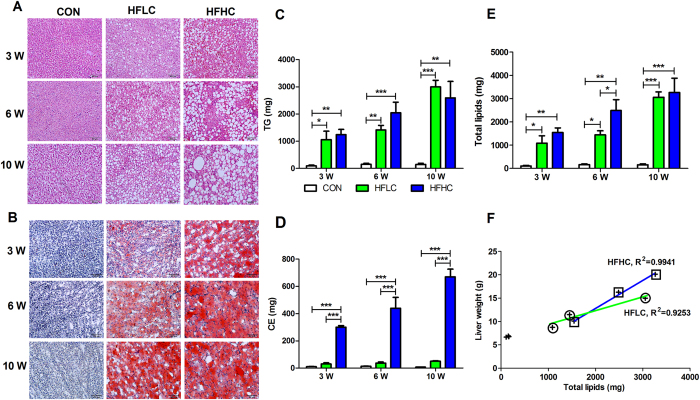
HFLC and HFHC caused lipid accumulation in liver.Liver histology showed that both HFLC and HFHC diets induced steatosis as indicated by hematoxylin-eosin (HE) staining (A), and Oil Red O staining (B). Scale bars: 100 μm. (C) Both HFLC and HFHC diets remarkably increased hepatic triglycerides (TG) content. (D) Only HFHC diet increased cholesterol esters (CE) in the liver. (E) Total lipids (TG + CE) in liver. (F) Linear relationship between liver weight and total lipids in HFHC (R2 = 0.9941) and HFLC (R2 = 0.9253). Data are presented as mean ± SEM of 3–4 animals. Significant difference between two groups, *P < 0.05, **P < 0.01, ***P < 0.001.